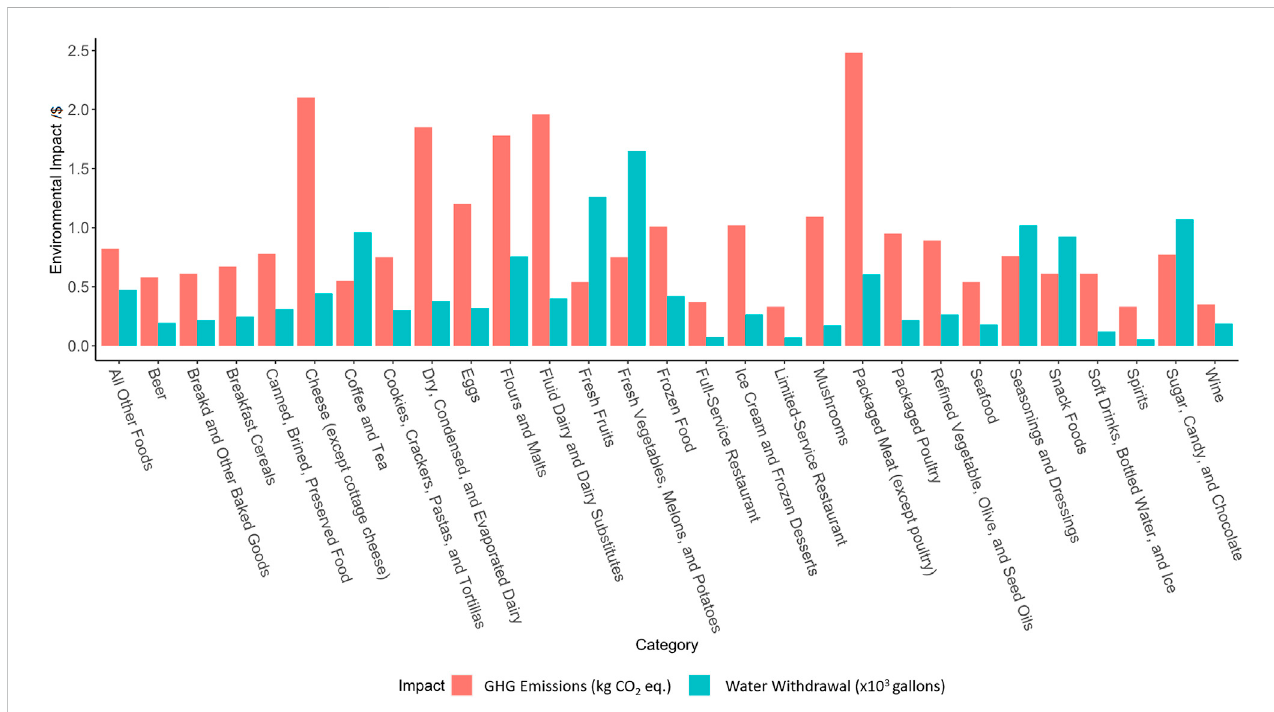
FIGURE 2 Environmental impact factors for calculation of greenhouse gas emissions (kg CO 2 eq.) and water withdrawal (gallons) resulting from food purchases (USD) (Yang et al.,